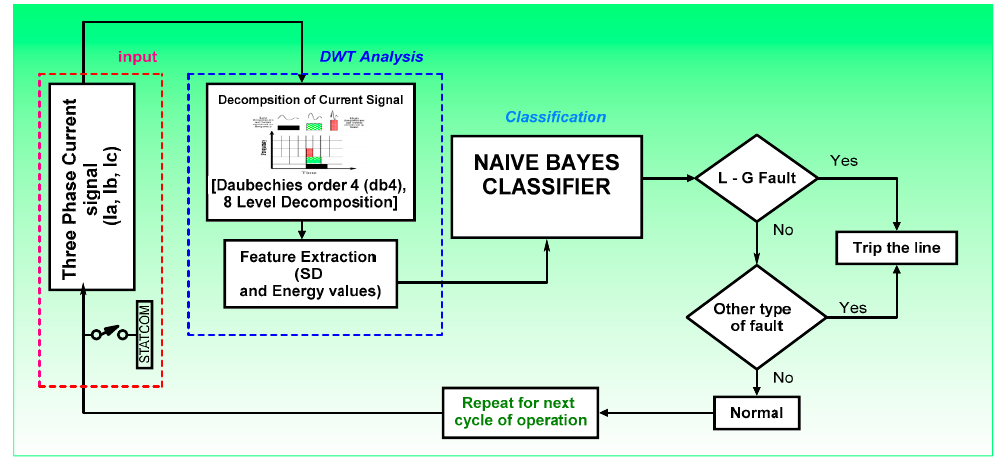
Figure 2. Proposed method of fault classification.